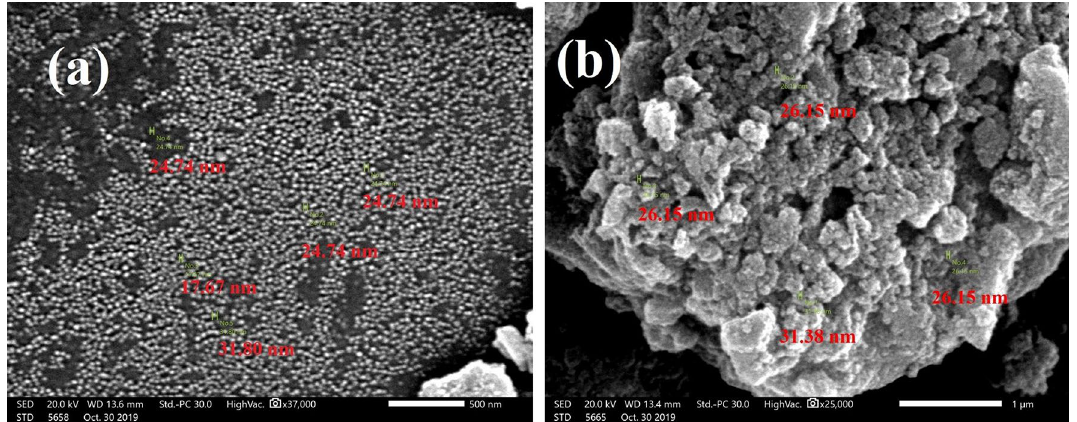
Figure 5. SEM micrograph of ( a ) OPAC under magnification of 37,000, ( b ) MG-OPAC under magnification of